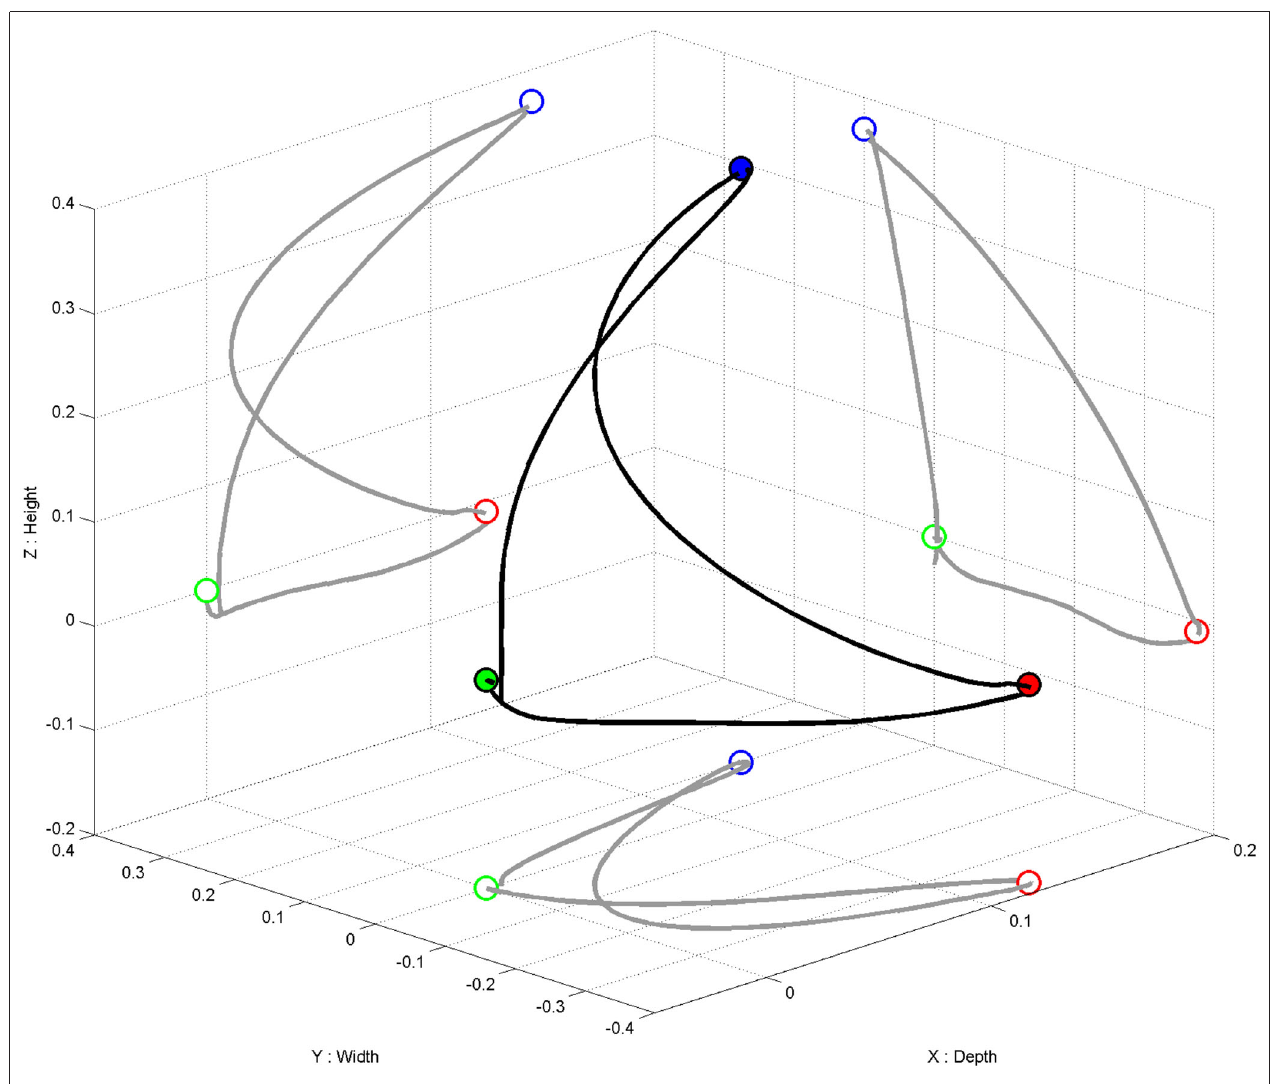
FIGURE 3 | Movement trajectory in three-dimensional space (in black). Projection (in gray) of the three-dimensional movement on the respective two-dimensional planes (i.e., axis-surfaces x/y , x/z , y/z ). Starting point (i.e., target 3) represented as a green dot, target 1 as a red dot, target 2 as a blue